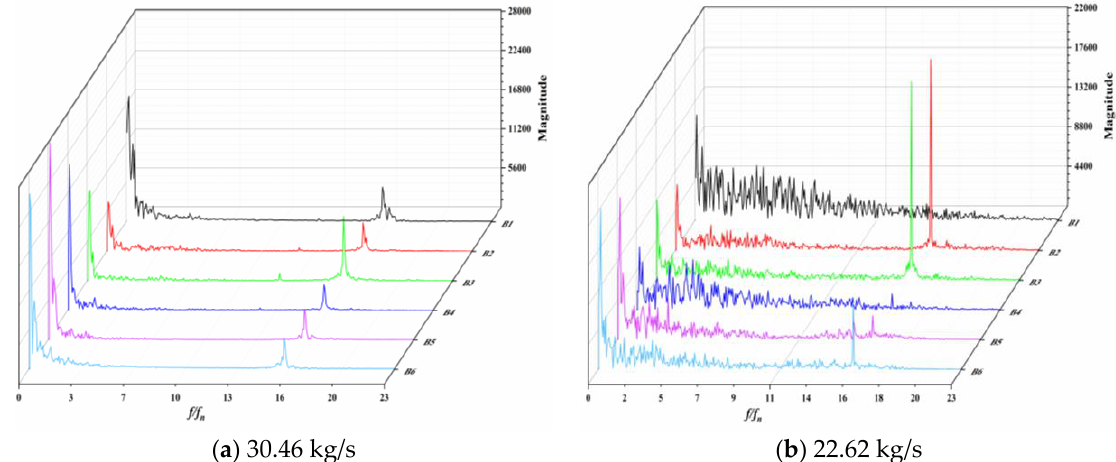
Figure 18. Amplitude spectrum of monitoring points in the vaneless diffuser.